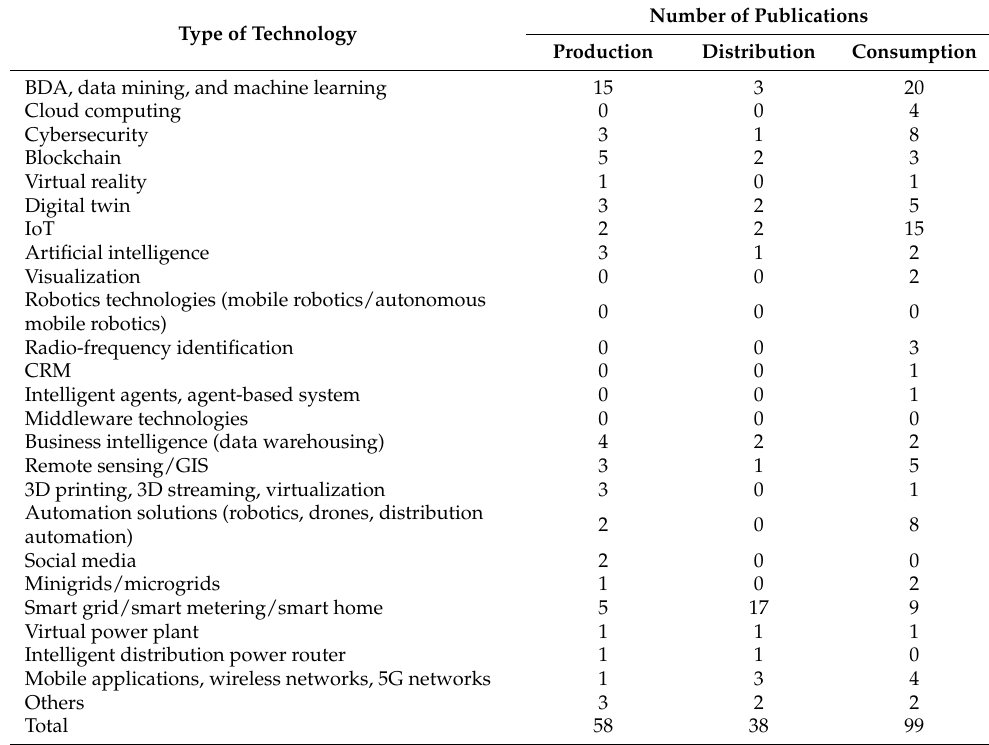
Table 5. Distribution of the technologies and systems in energy sectors 1